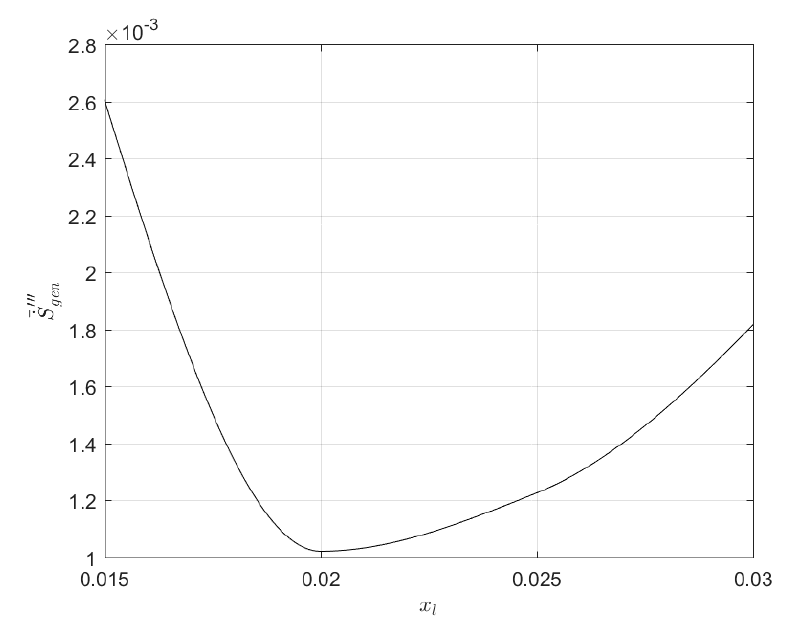
Figure 5. Generated entropy vs. the gap between lamps for N r = 10 and A R = 1/2.